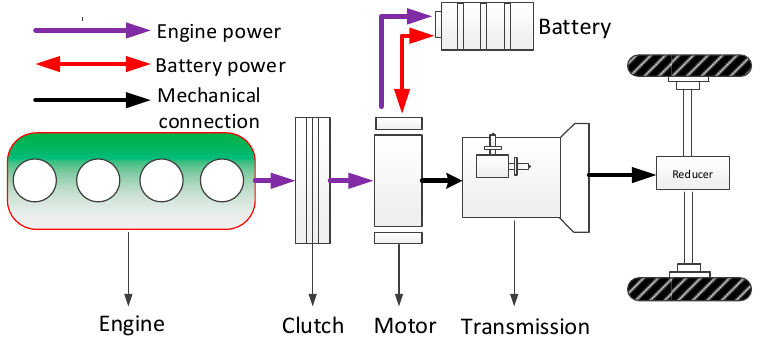
Figure 2. Parallel hybrid electric vehicle.